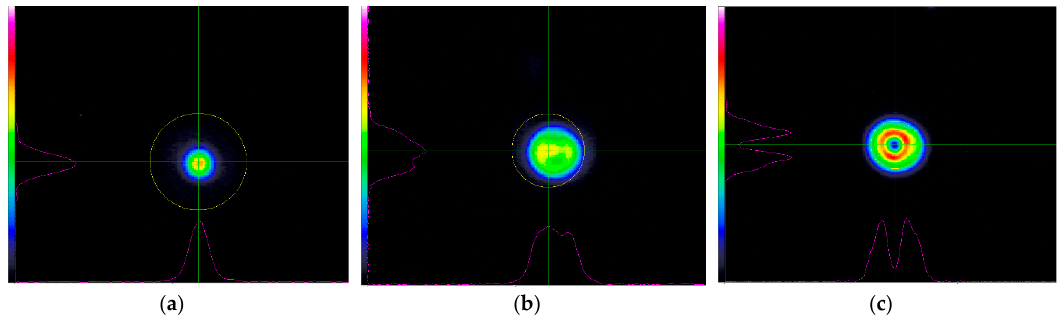
Figure 4. The data from a charge-coupled device (CCD) camera withe the obtained laser beam profiles: ( a ) Gauss; ( b ) flat top (top hat); ( c ) donut (bagel).